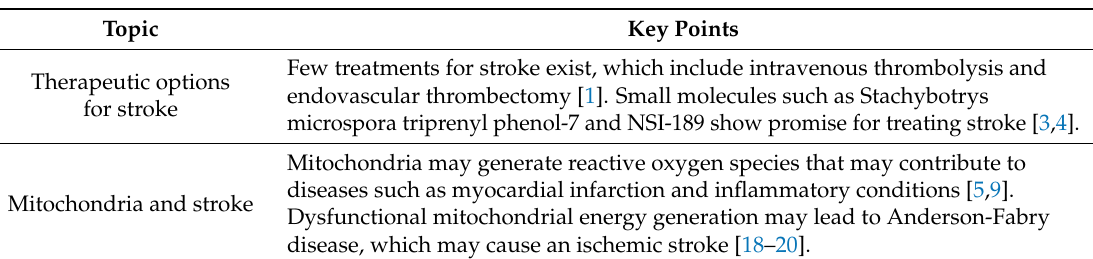
Table 1. Summary of discussed topics and associated key findings.